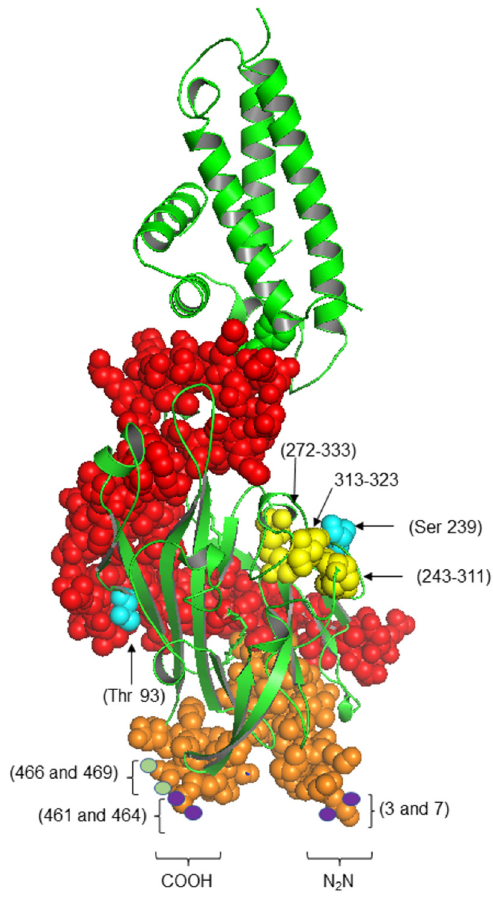
Figure 4. Three-dimensional structure of FAT/CD36 protein. The image represents the sites of the functional relevance of the FAT/CD36 protein. In orange, the intracellular amino and carboxyl-terminal domains, two phosphorylation sites (blue), four palmitoylation sites (purple), three disulfide bond sites (yellow), and two ubiquity sites (green). In red, the hydrophobic pocket is represented through which the fatty acids are presumed to be transported to the outer membrane—a model designed with 5LGD: X-ray Diffraction, 2.07 Å. “The CIDRa domain from MCvar1 PfEMP1 bound to CD36” data deposited and modeling in the SWISS-MODEL database. The graphs were visualized in the PyMOL 4.6.0. program.